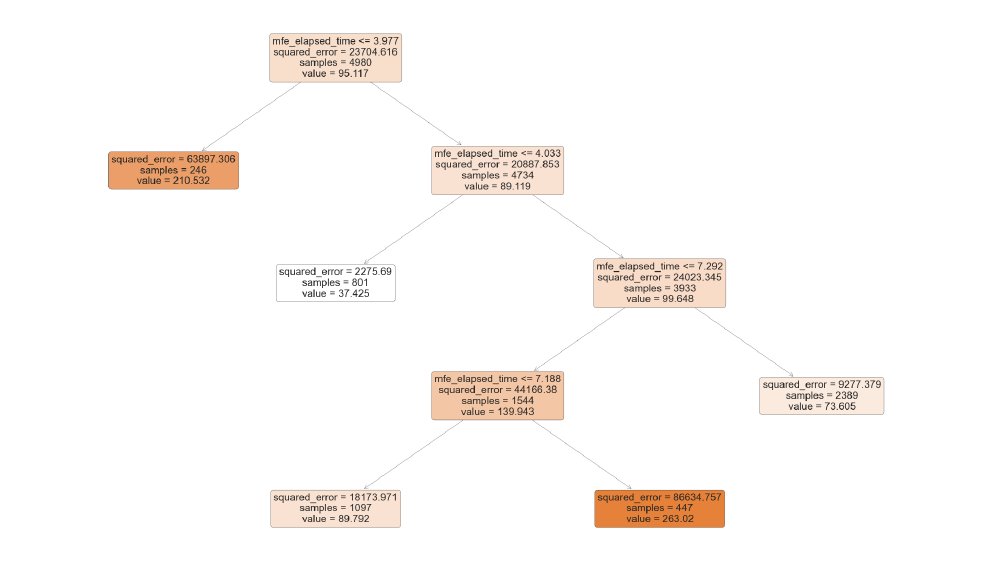
Figure 6. Visual representation of an oversimplified tree to predict training time from meta-feature extraction time: the relationship is not